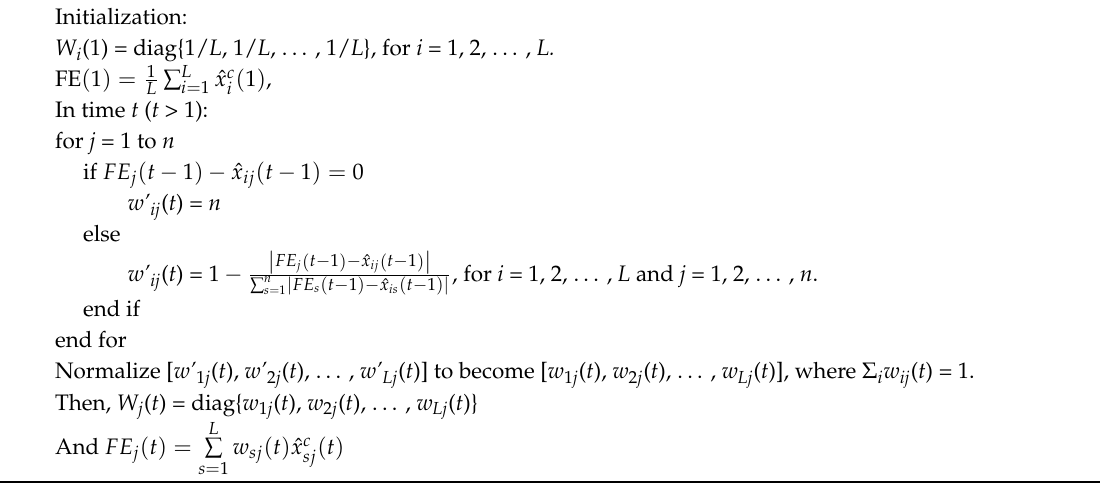
( t ) ( t ) , ˆ x c ( t ) , . . . , ˆ x c L 2 1